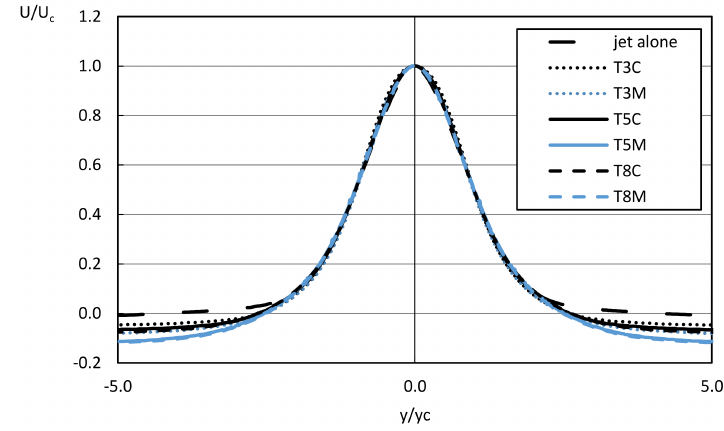
Figure 13. Normalized longitudinal velocity, in a cross section taken at 780 m from the jet inlet in the case of jet alone and with the superimposed wave propagation with peak periods of 3 s, 5 s and 8 s.